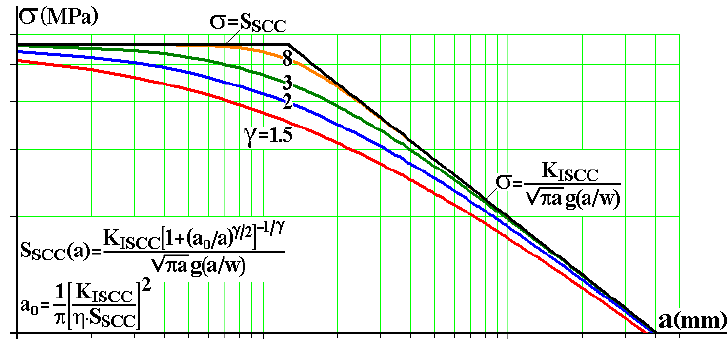
Figure 5: A Kitagawa-Takahashi-like plot proposed to describe the environmentally assisted cracking behavior of short and deep flaws for structural design